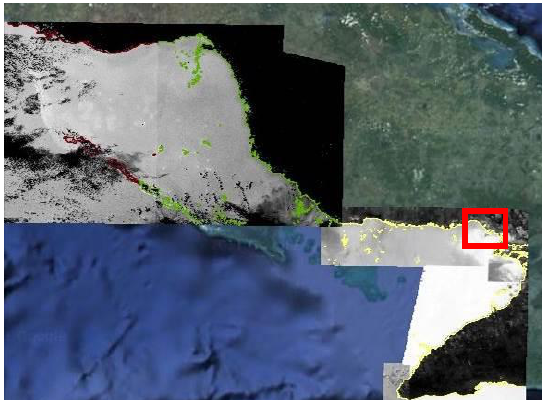
Figure 3. SENTINEL-2 images transformed to NDWI over Google Earth.